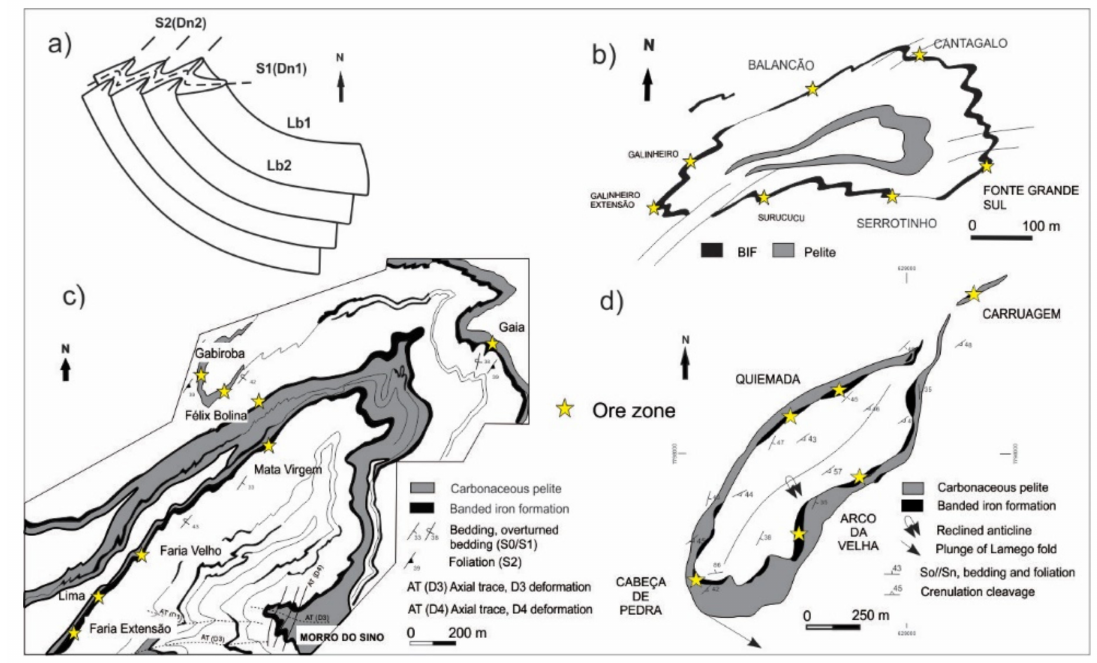
Figure 6. Fold interference pattern in the Nova Lima and Caet é districts. ( a ) Type 3 fold superposition [110] as proposed by [111]; ( b , c ) isoclinal folds with Z-shaped interference pattern in Cuiab á (modified from [16,93]) and Faria (modified from [18]) deposits; ( d ) Lamego isoclinal intrafolial fold (modified from